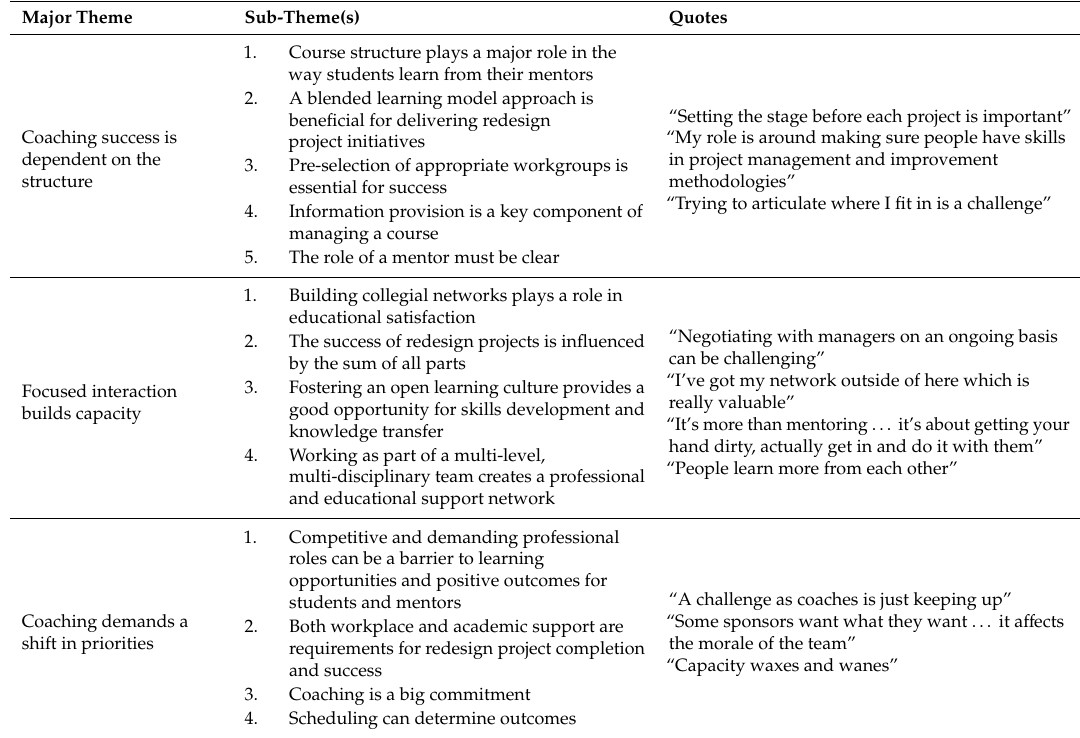
Table 4. Themes from expert coach